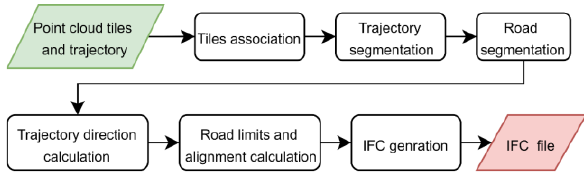
Figure 3. Proposed methodology workflow.